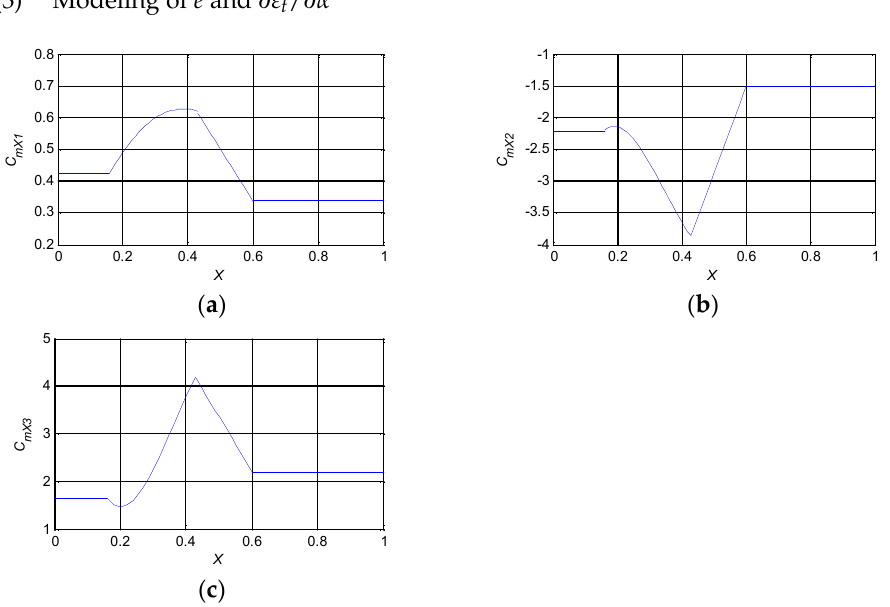
Figure 8. Spline curves of correction coefficients of pitching moment. ( a ) C mX 1 − X ; ( b ) C mX 2 − X ; ( c ) C mX 3 − X .